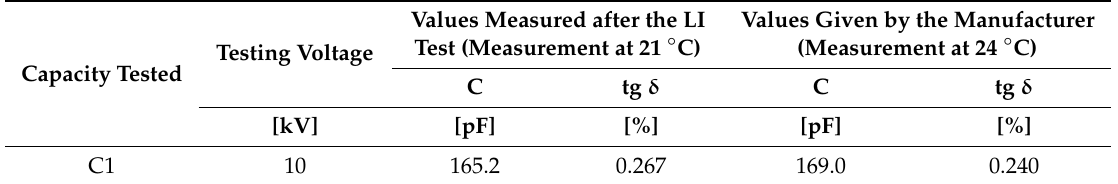
Table 7. Results of the measurements of tg δ and capacity for the bushing of the phase 1U set with the values of these parameters given by the